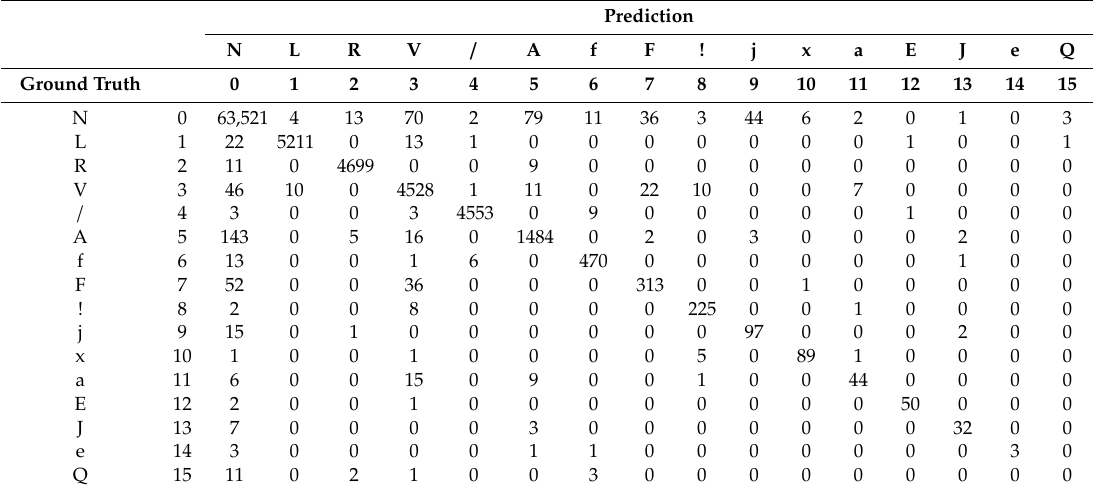
Table 6. Confusion matrix for [256 256 256] ensemble of CNNs.